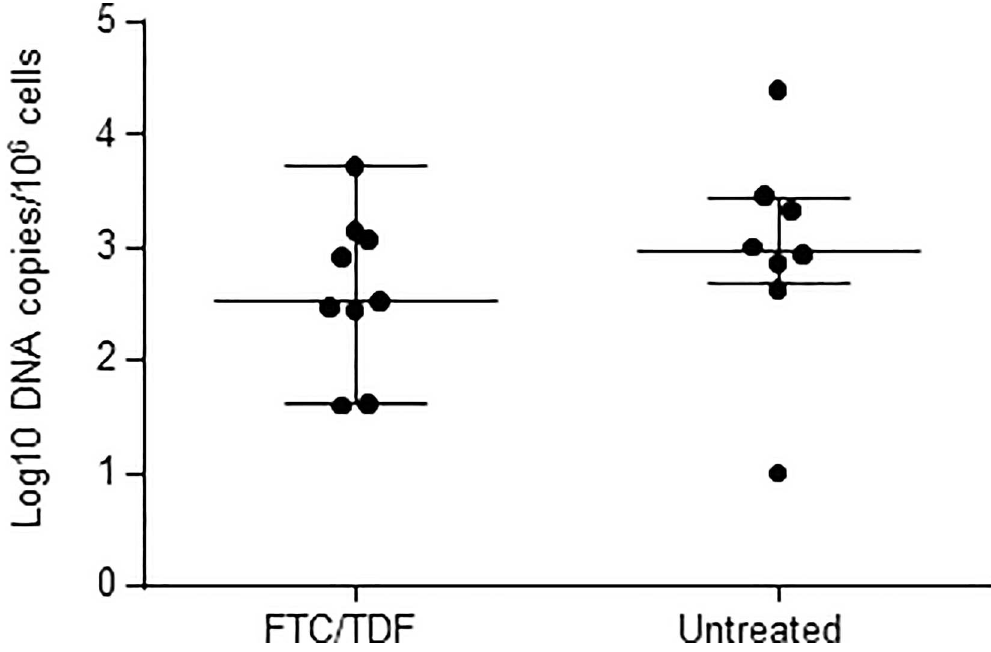
Fig 4. SHIV 162P3 DNA levels in lymphoid tissues collected from PrEP breakthrough infections and untreated controls. Each individualpoint corresponds to the median SHIV DNA value observed in mesenteric, axillary, and inguinallymph nodes from one macaque. Overall SHIV DNA levels in FTC/TDF PrEP breakthrough infections were not significantly different from those seen in placebo infections ( p = 0.34). Horizontal lines are median values observed in each group. Vertical lines are